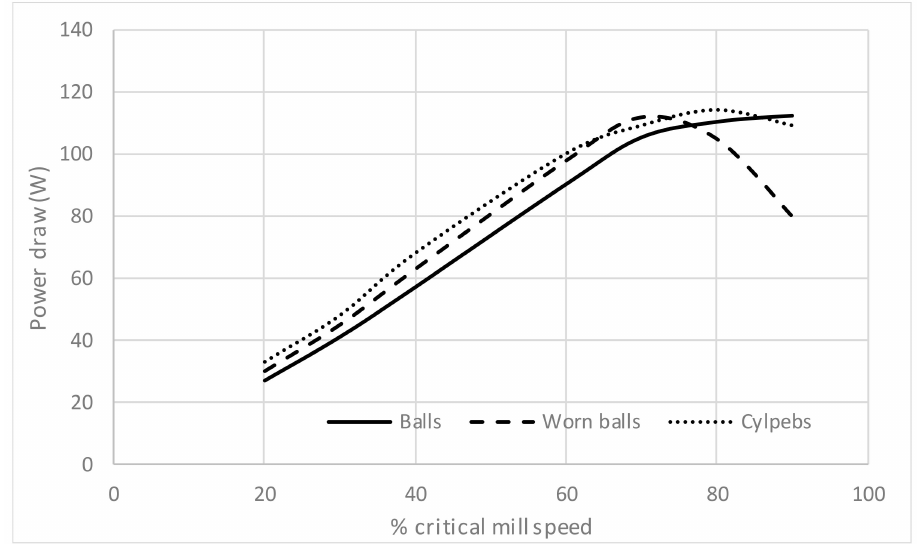
Figure 2. Power variation with mill speed for different media shapes (adapted from [16]).